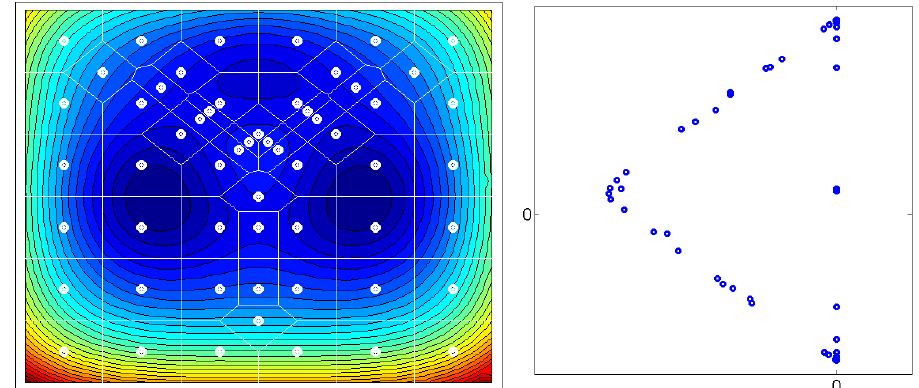
Figure 1. Left: A 2-dimensional state space Ω is decomposed into 57 subsets via a Voronoi tessellation. The potential energy surface has three local minima (contour lines). After calculation of transition probabilities due to a potential-driven diffusion process, a transition matrix P ∈ R 57 × 57 is generated. Right: The leading three eigenvectors of P are computed, i.e., X ∈ R 57 × 3 is determined. The first eigenvector is a constant vector. The 57 entries of the second and third eigenvector are plotted as 2-dimensional points. One can clearly see the simplex structure. Those points located at the vertices of this simplex belong to Voronoi cells covering the energy minima of the potential energy